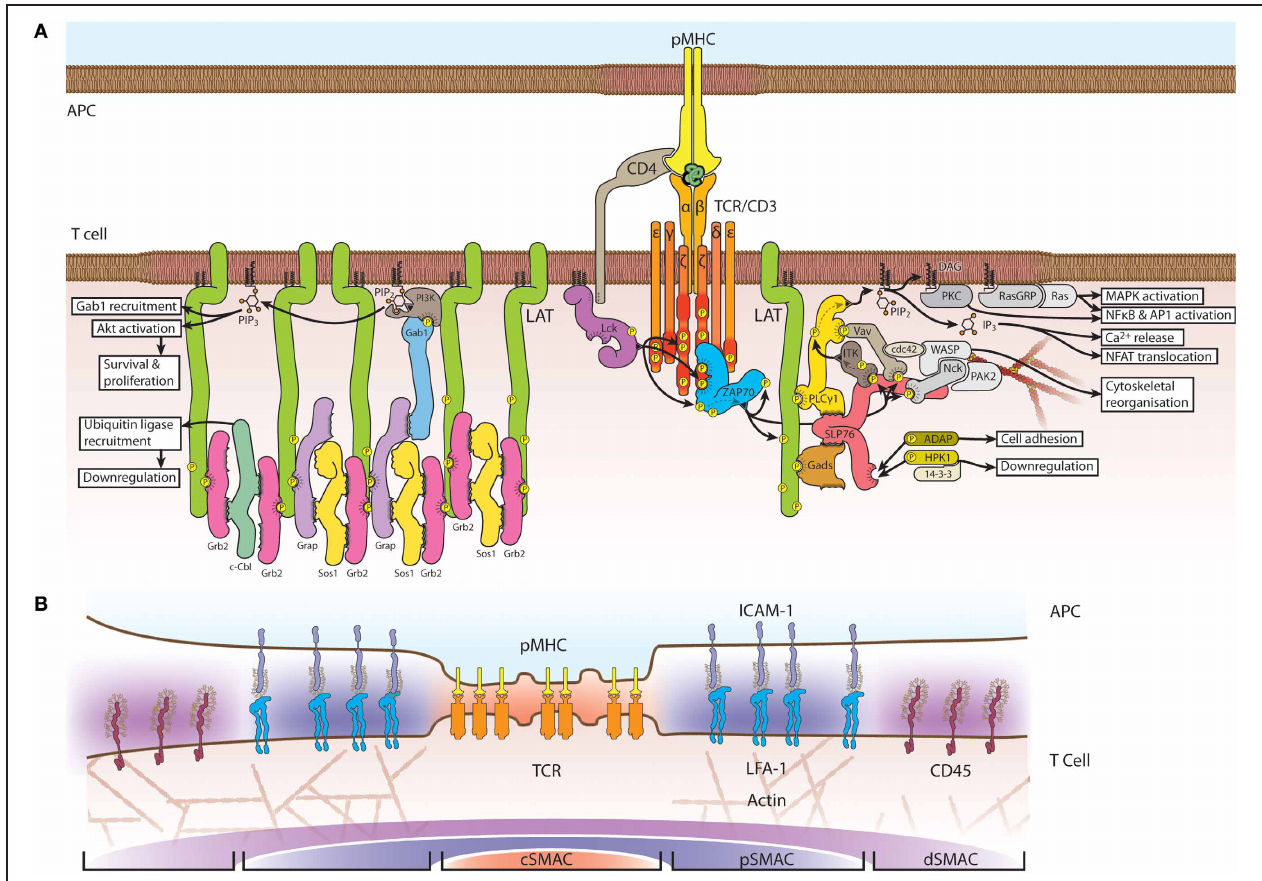
effectors; multi-point binding options between LAT, Grb2, Sos1 and Grap facilitate the formation of an extended protein network. LAT-nucleated signaling also occurs through Gads and SLP76. (B) At larger scales, the immunological synapse forms into distinct supramolecular activation clusters (SMACs), with the central SMAC (cSMAC, orange) rich in TCRs. Surrounding this layer is the peripheral SMAC (pSMAC, blue) enriched in signaling cofactors and adhesion complexes. A further region, the distal SMAC (dSMAC, purple) comprises glycoproteins such as CD45 and